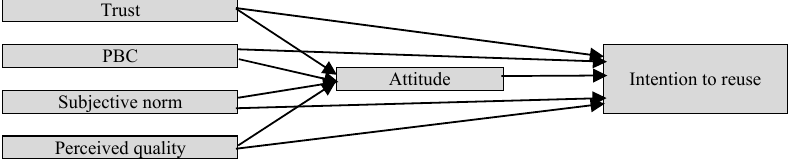
Fig. 1. Research Conceptual